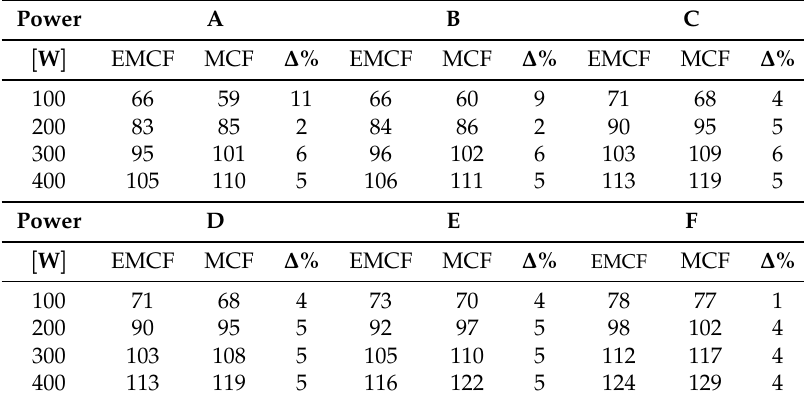
Table 4. Upper limit cadences ( C lim [rpm]) obtained with EMCF and MCF at different power outputs for the group of six cyclists considered for simulations.